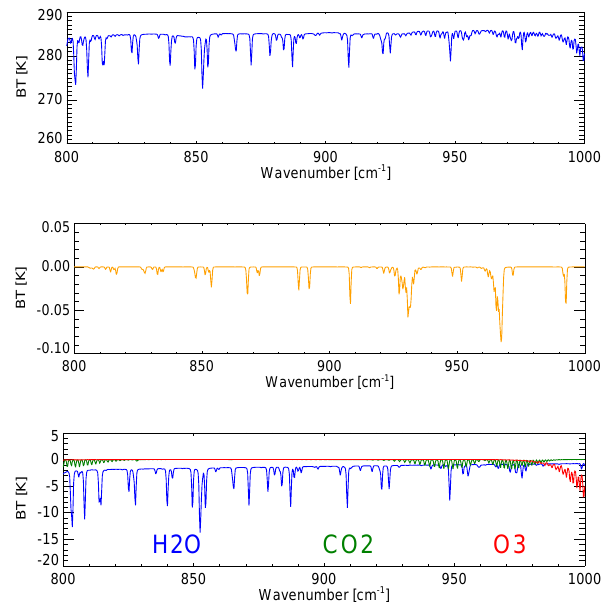
Fig. 9. Simulated spectra in the region of the ammonia ν 2 band. Top panel shows a simulated spectrum for a standard atmosphere. Middle panel shows contribution of background levels of ammonia. Bottom panel shows contribution of main interfering species (water vapour, CO 2 and